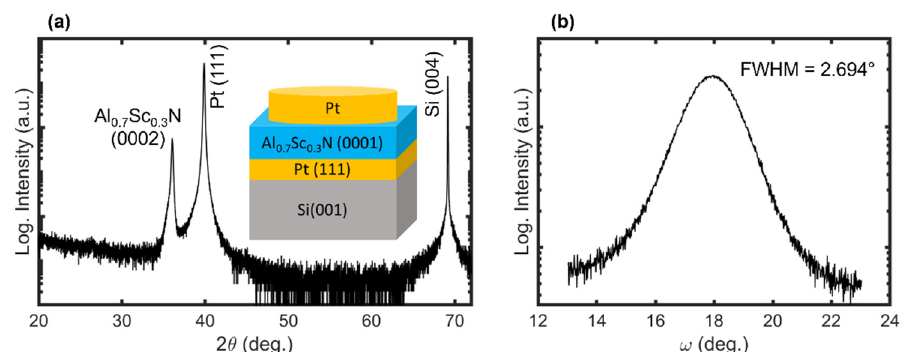
Figure 2. ( a ) The 2 θ – θ XRD scan of the investigated sample revealing a pure wurtzite phase with c − axis texture. The inset depicts the stacking sequence of the metal–ferroelectric–metal capacitor. ( b ) ω rocking scan of the Al 0.7 Sc 0.3 N (0002) peak.